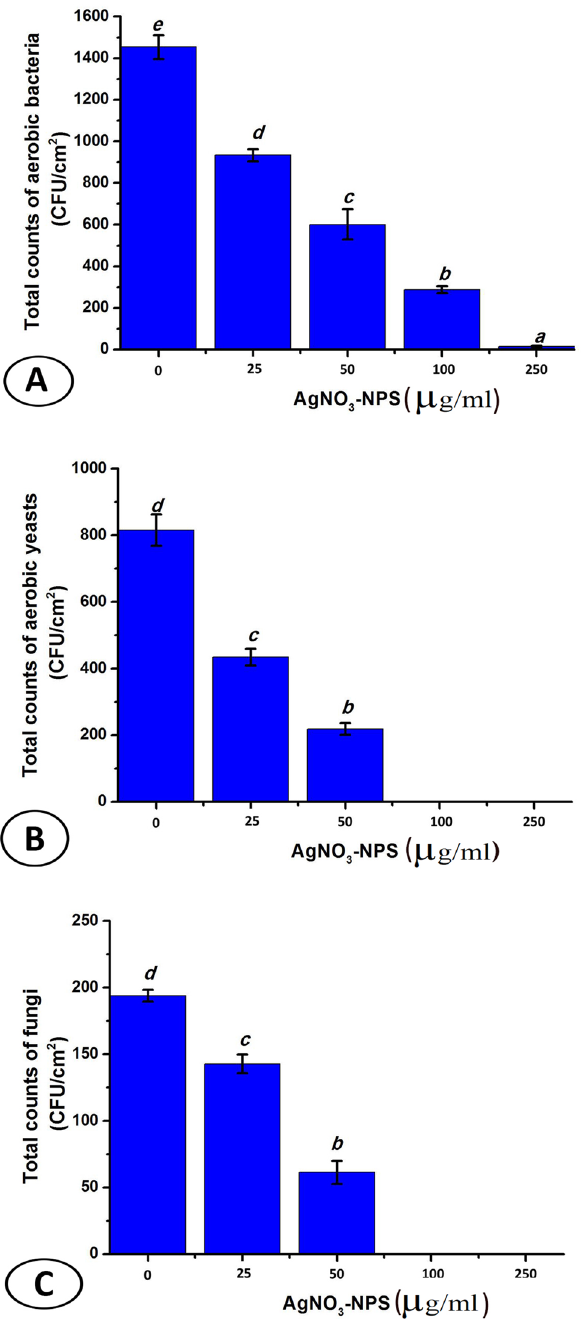
Figure 1. Total accounts (CFU/cm 2 ± SD) of aerobic bacteria ( A ), aerobic yeasts ( B ), and aerobic filamentous fungi ( C ) on fish skin sterilized with different concentration of Ag NPS (0, 25, 50, 100, 250